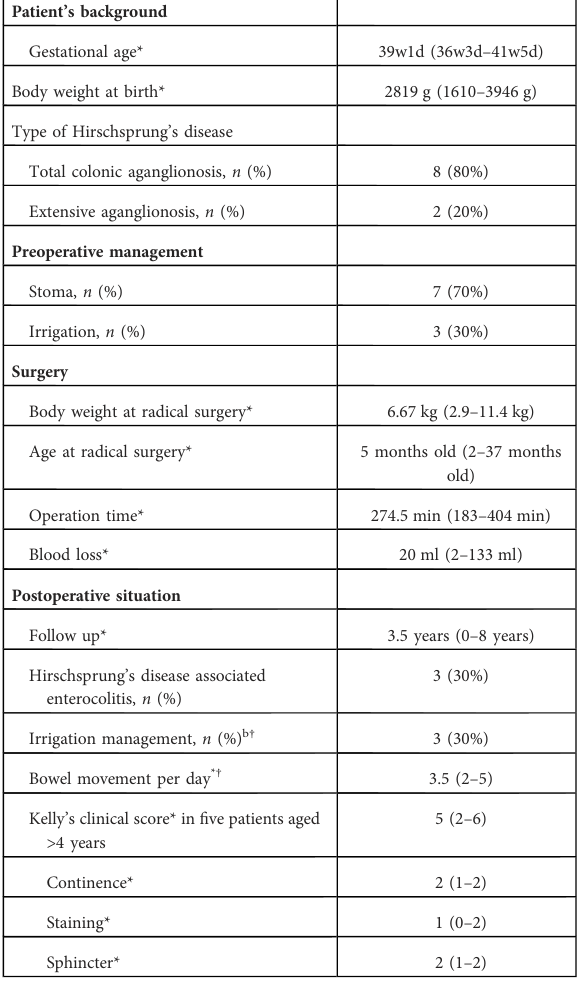
TABLE 1 Details of the study